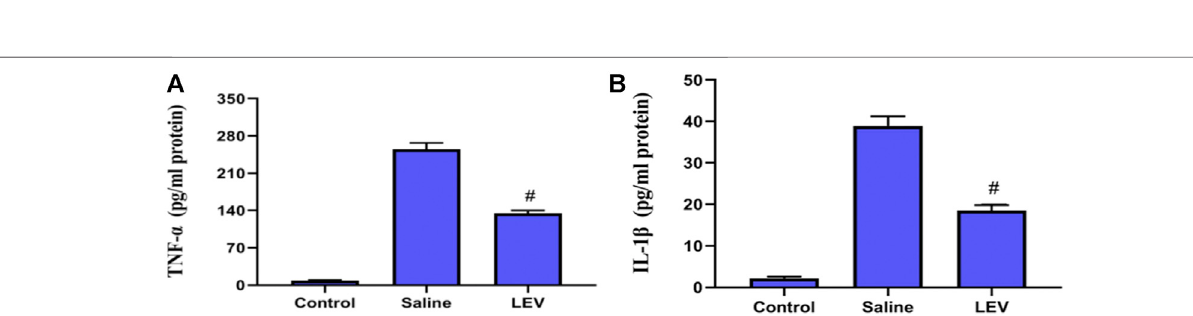
FIGURE5| Levetiracetam (LEV) exhibitsanti-in fl ammatorypropertiesinthe cerebral cortex ofthe ischemic brain. (A) PhotographsofOX-42 – immunopositive cells in the cortex after cerebral infarction (original magni fi cation: × 200). (B) The number of OX-42 – immunopositive cells 14 days after ischemia in the cerebral cortex. N (cid:1) 12 per group. # p < 0.01 compared to the saline and control groups.